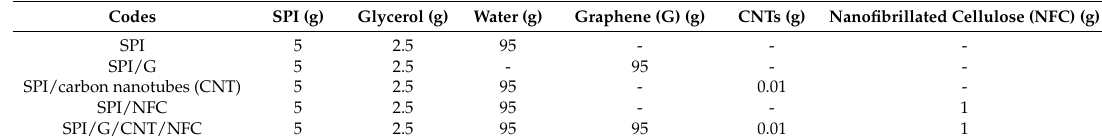
Table 1. Experimental details and summary of the soy protein isolate (SPI) based films.